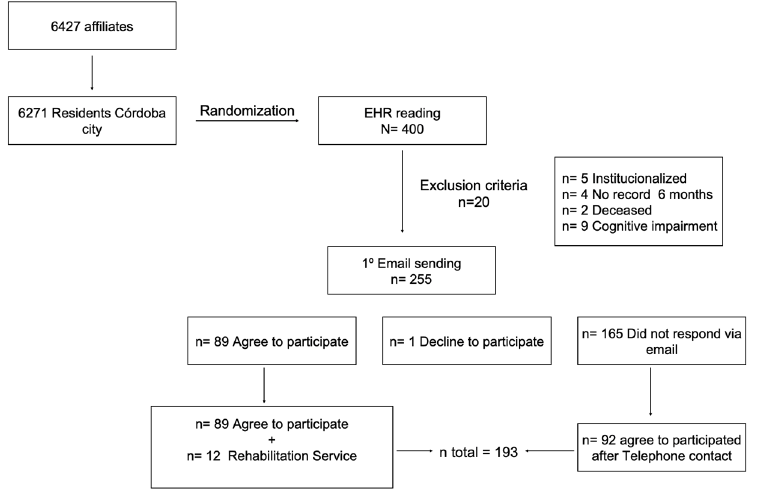
Figure 1. Flow Diagram.